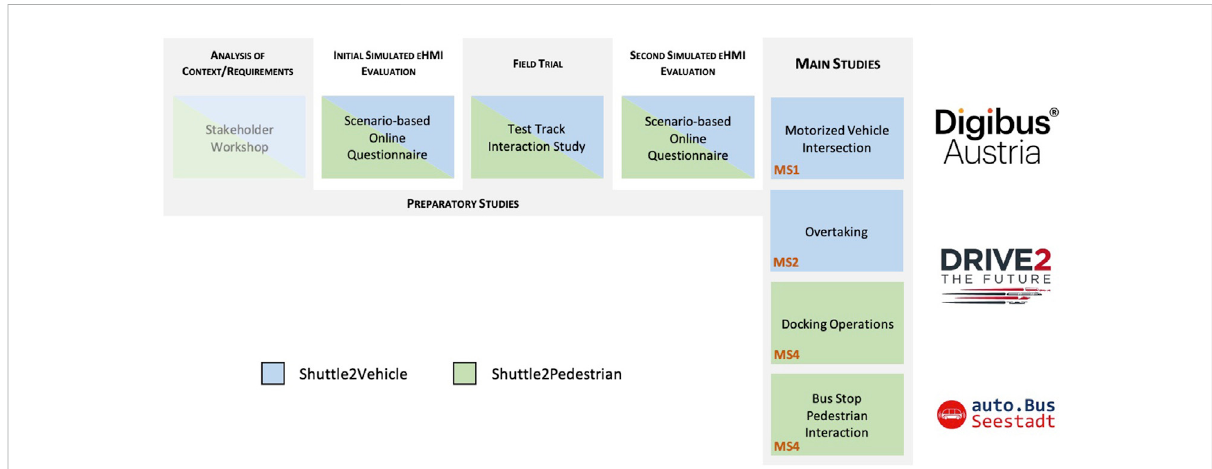
FIGURE 1 Overview of all studies included in this publication from each participating research project. Note: The stakeholder workshop was the general startingpointfeedingintoallfurtherresearchactivities.Forreasonsofclarityandscope,itsexactprocedurewillnotbediscussedfurtherinthisstudy, but the key data and essential fi ndings are outlined as part of Section 4.1, as its essential fi ndings were immediately applied in the fi rst online questionnaire